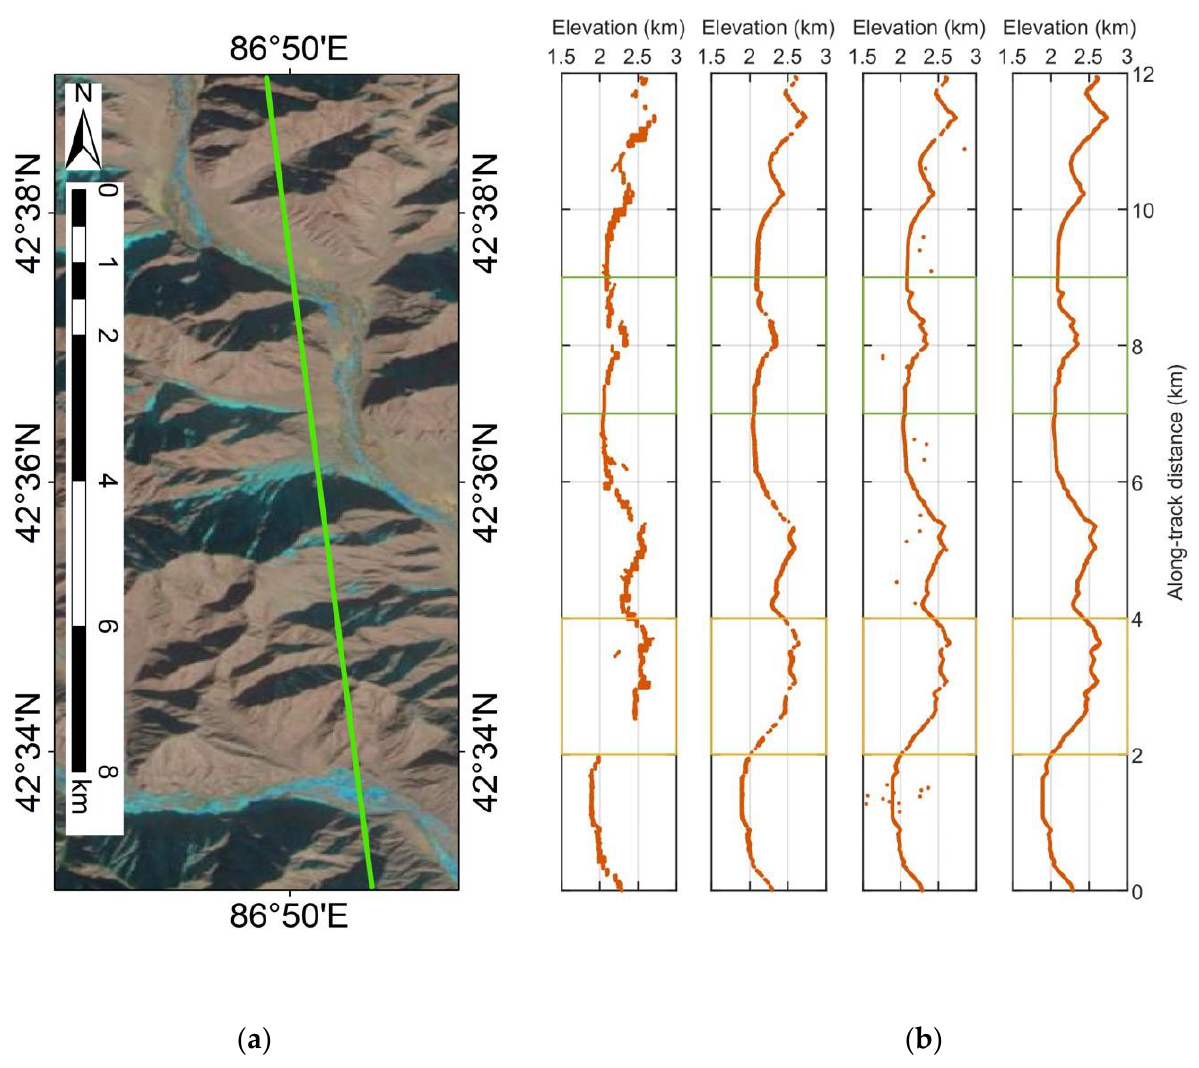
Figure A3. ( a ) ICESat-2 ATLAS ground track (a descending track) and satellite imagery in the Tian Shan Mountains. The Tian Shan Mountains are located between the Tarim Basin and the Junggar Basin, which are the farthest mountains to the sea around the world. ( b ) The signal photons extracted by different methods. The diameter and threshold of the classical DBSCAN were set as 5.5 m and 5, respectively. Two sampled segments within the yellow and green boxes were enlarged and illustrated in Figure A4a,b to show the details, respectively.